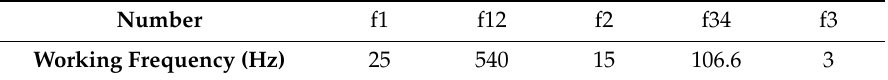
Figure 6. Three different fault patterns of gears.